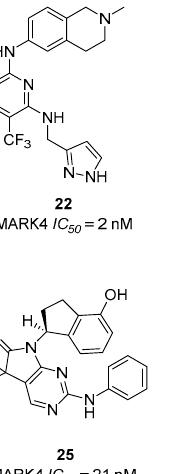
Figure 6. Representatives of weak and moderate MARK4 inhibitors with the activity descriptors; ( a ) the weak 3-N-aryl substituted-2-heteroarylchromoneinhibitor 14 [54] in comparison to the moderate 3-benzoylcoumarinMARK4 inhibitor; ( b ) the moderate inhibitors from various heterocyclic families 15 [55], 16 [56], 17 [57], 18 [58], 19 [59], 20 [60], 21 [61]; ( c ) MARK4 inhibitory properties of rivastigmine and donepezil [50]. To compare the activity expressed in various ways (IC50, K d or %inhibition at a given concentration), the formal inhibition activity descriptor (FA) was used, i.e.,: